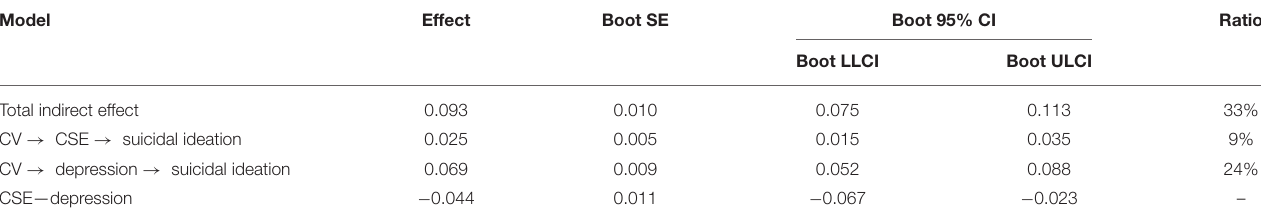
TABLE 3 | Indirect effects with core self-evaluation and depression as